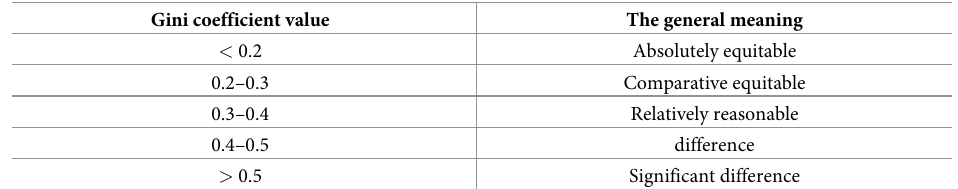
Table 1. Gini coefficient classification